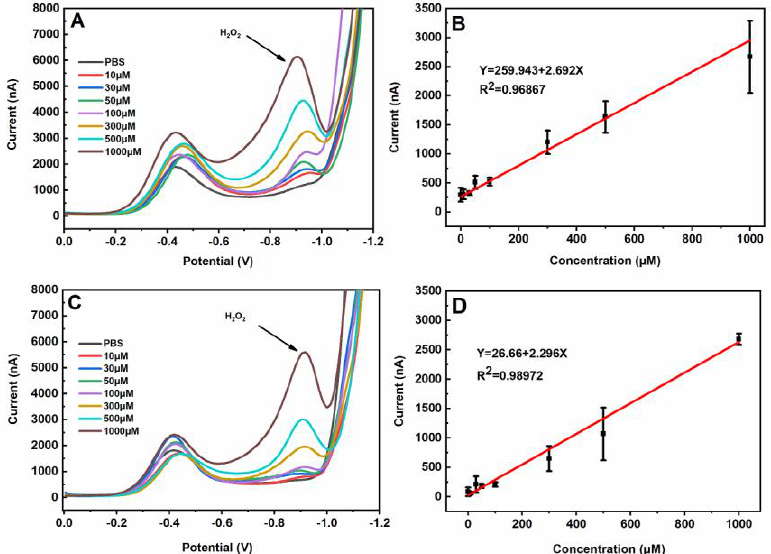
Figure 3. The di ff erential pulse voltammetry curves of H 2 O 2 with di ff erent concentrations (0~1000 µ M) on the nano-gold-modified ITO electrodes ( A ) and the calibration curve between the di ff erential pulse voltammetry peak currents and the H 2 O 2 concentrations in the air ( B ), the di ff erential pulse voltammetry curves of H 2 O 2 with di ff erent concentrations (0~1000 µ M) on the nano-gold-modified ITO electrodes ( C ), and the calibration curve between the di ff erential pulse voltammetry peak currents and the H 2 O 2 concentrations in the N 2 atmosphere ( D ). The average values and standard deviations were obtained based on 6 replicates.